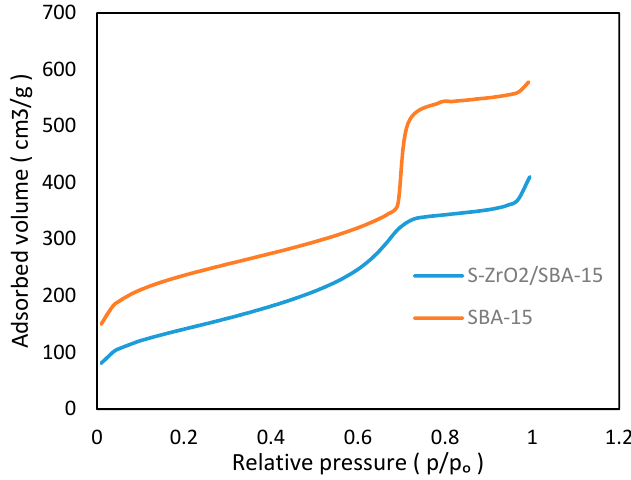
Figure 1. N 2 adsorption and desorption of the isotherms of the support SBA-15 and catalyst S-ZrO 2 /SBA-15. Table 4. Physiochemical properties of the